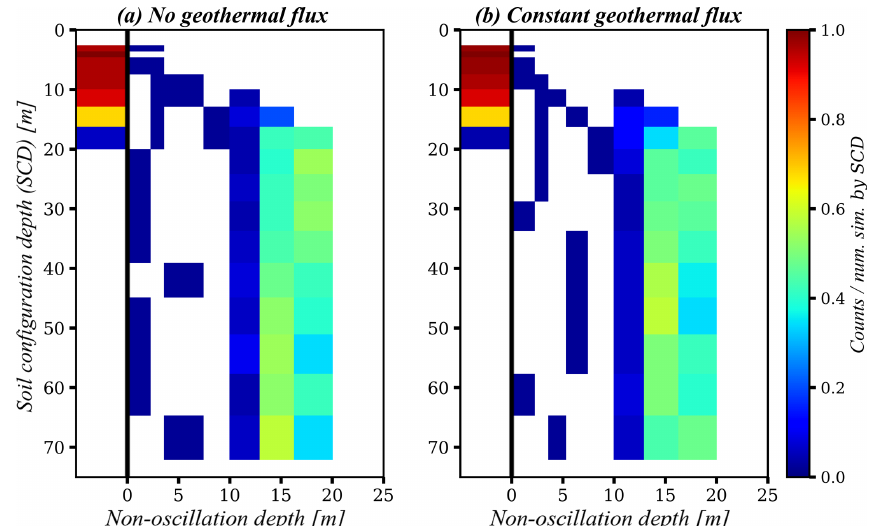
Figure 13. The 2-D histogram of SCD and h T -non-oscillation depth. Counts are normalized by the number of simulation by SCD. The black line represents the limit at which the conditions reach or do not the h T -non-oscillation conditions. Bins to the left represent SCDs that never reach the h T -non-oscillation condition. (a) no geothermal flux; (b) constant geothermal flux as lower boundary condition at the bottom of the soil layers.